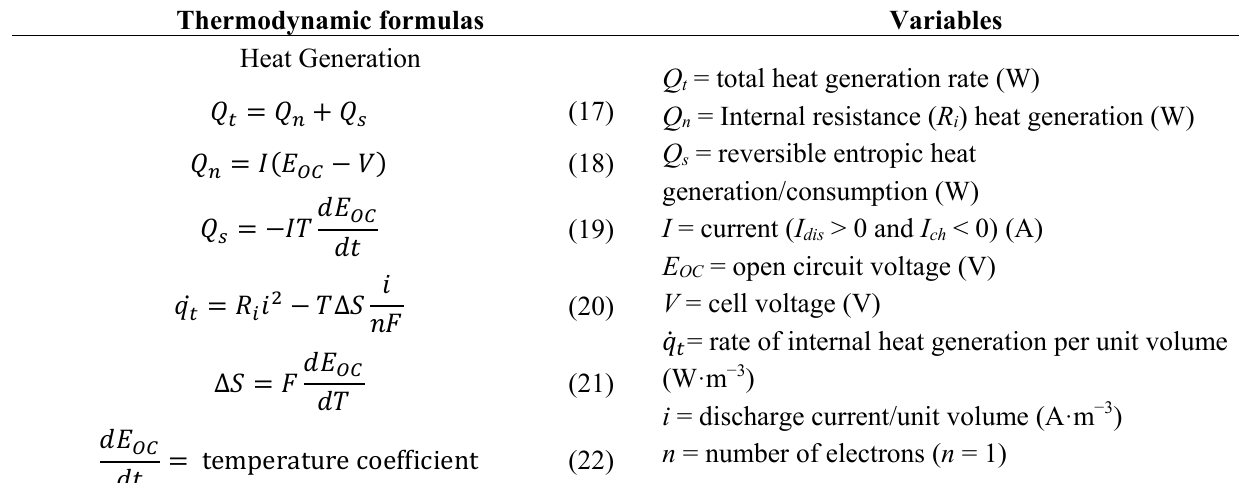
Table 2. Thermodynamic formulas used in the two-dimensional transient finite element analysis thermal model